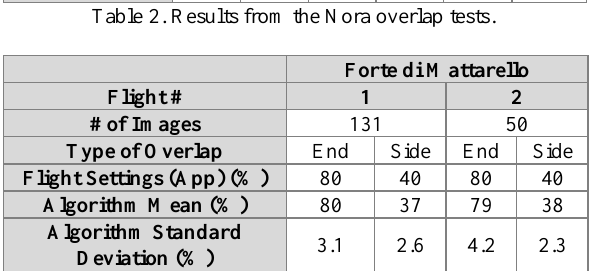
Table 3. Results from the Forte Mattarello tests.